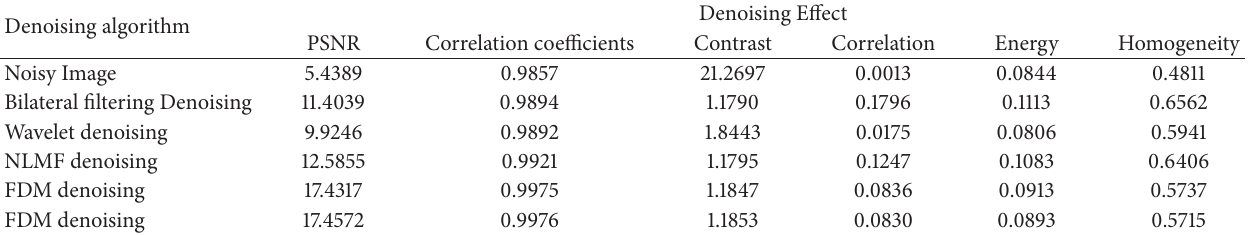
Table 3: Denoising effects of abdomen MRI of texture-rich internal organ, when Gaussian noise is very strong. Denoising